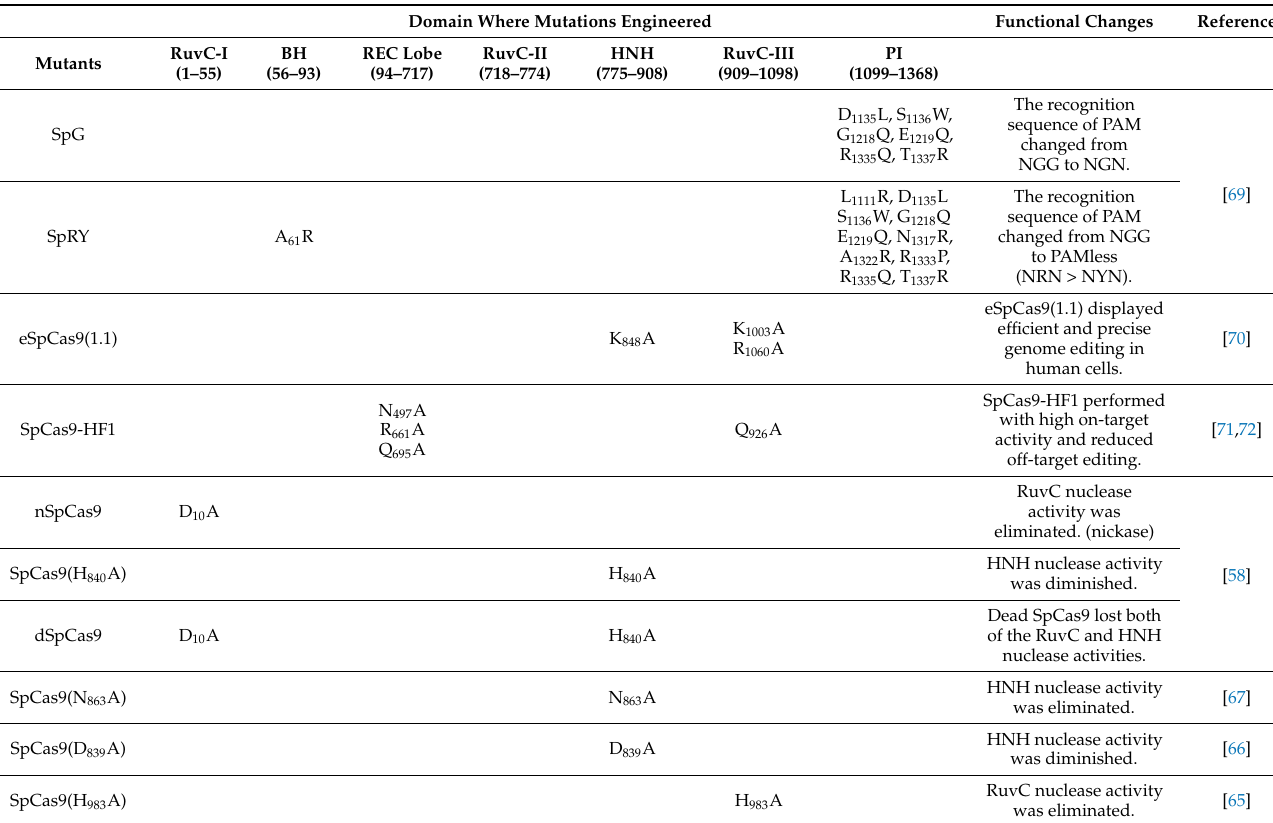
Table 1. The engineered mutations of SpCas9 on target site recognition and nuclease